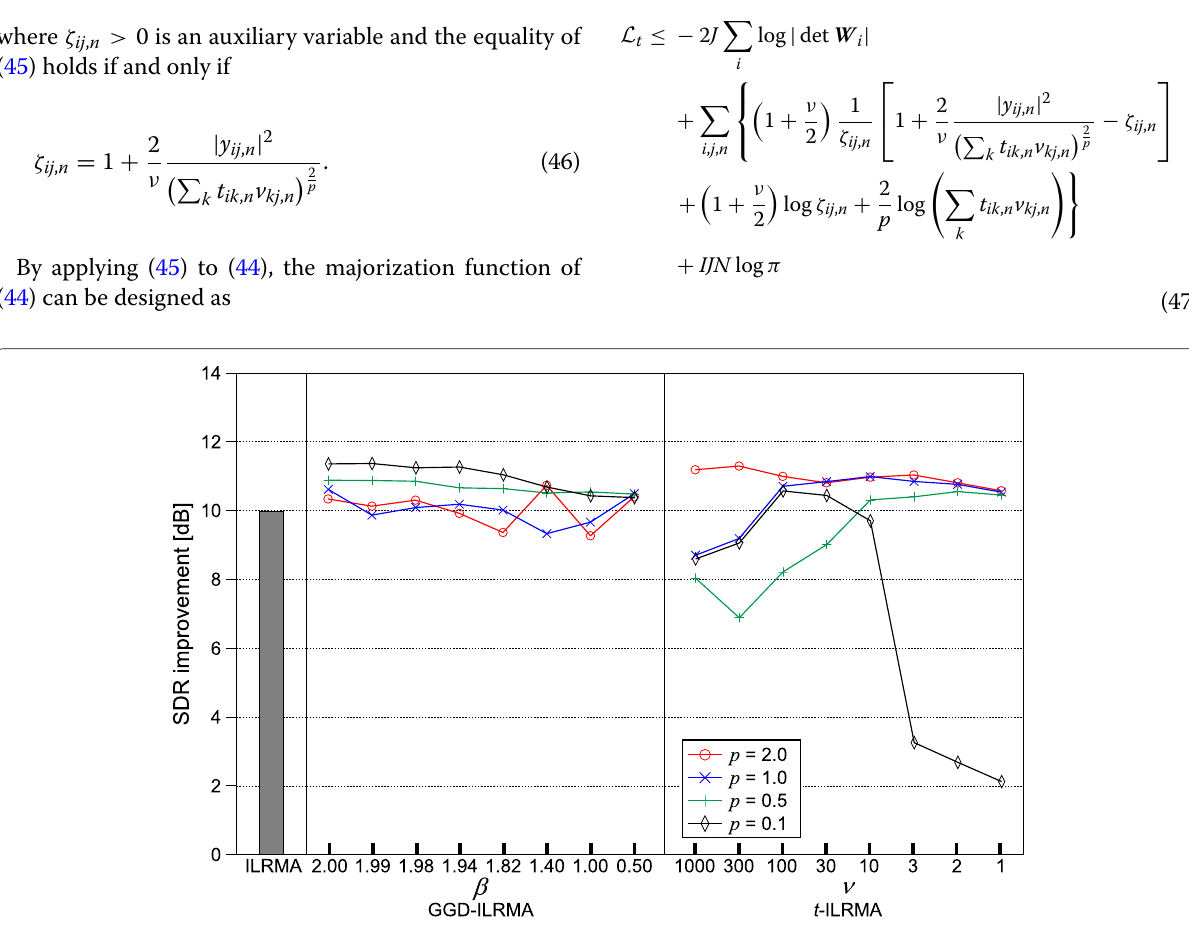
Fig. 19 Average SDR improvements of Speech 4 with E2A_1 signal using parameter